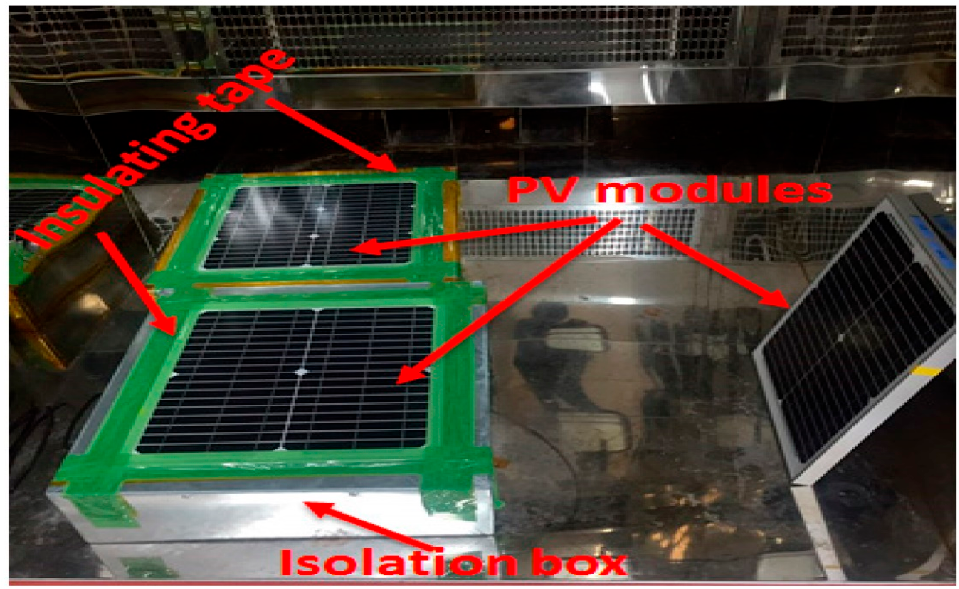
Figure 13. Optical image of photovoltaic (PV) modules inside the thermal cycling chamber [67].